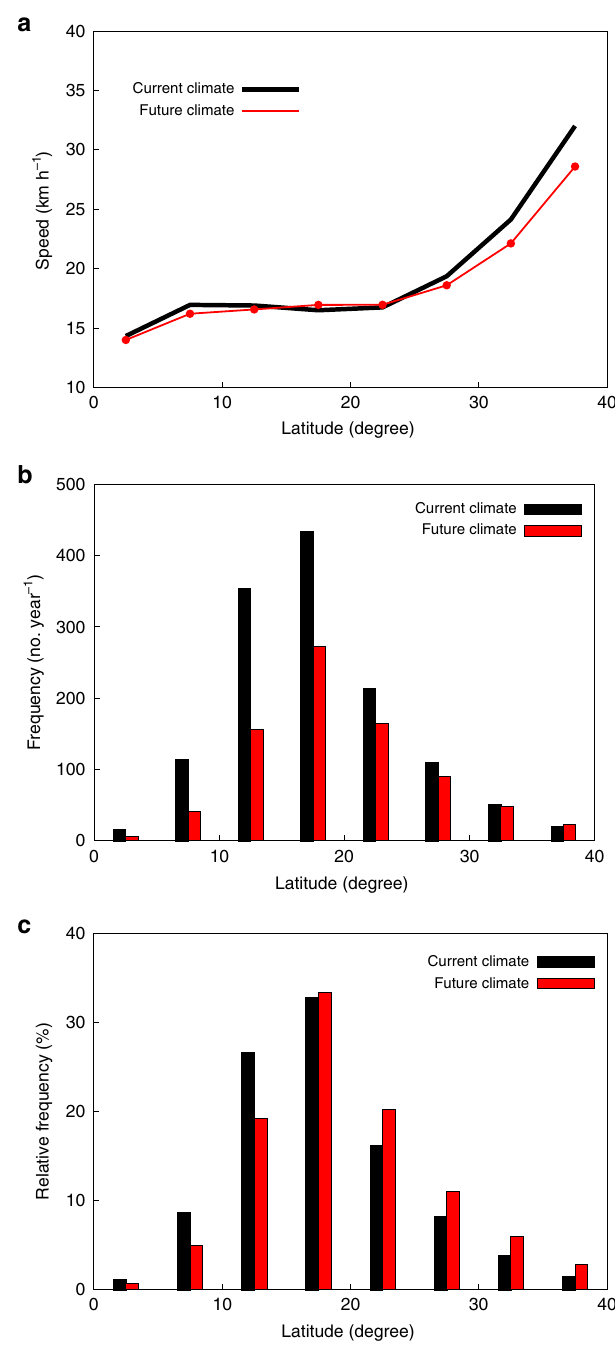
Fig. 3 Changes in the tropical cyclone translation speed, tropical cyclone absolute, and relative frequency against latitudes. a – c The range of the latitude is 0 – 40° with 5° interval, and the speed and both frequencies are globally averaged at each latitudinal bin. Red (black) line ( a ) and boxes ( b , c ) is for the future (current) climate. The difference between the current and future climates is statistically signi fi cant at a 99% level ( p < 0.01, two- tailed Student ’ s t test) at each bin for a – c